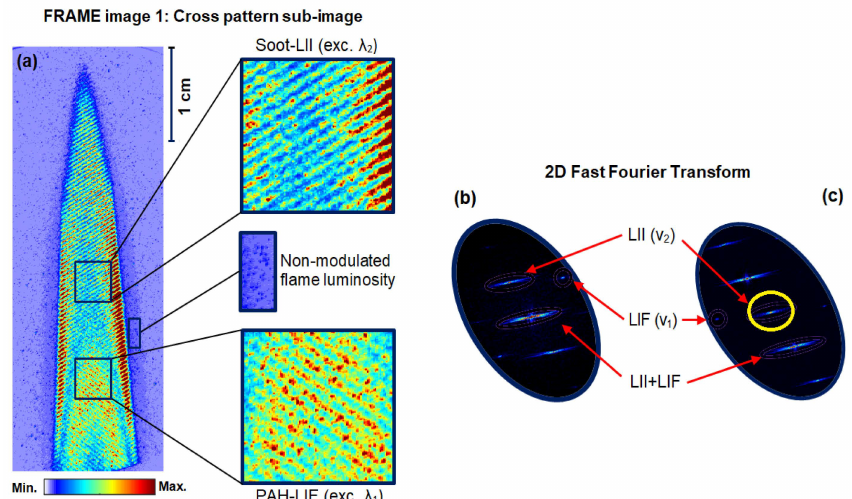
Figure 1. ( a ) FRAME image 1: single-shot unprocessed sub-image of both PAH-LIF and soot-LII signals recorded using a single camera. Zoomed view: The LIF and LII signals generated by two laser excitations ( λ 1 , λ 2 ) are modulated and flame luminosity including stray lights are non-modulated signals. ( b ) Two-dimensional (2D) FFT of the image in ( a ), showing two signals appearing at di ff erent locations in the frequency domain (Fourier space). In ( c ), 2D FFT of a resulting image generated from the multiplication of sub-image data in ( a ) and a sinusoidal reference signal of spatial frequency ( ν 2